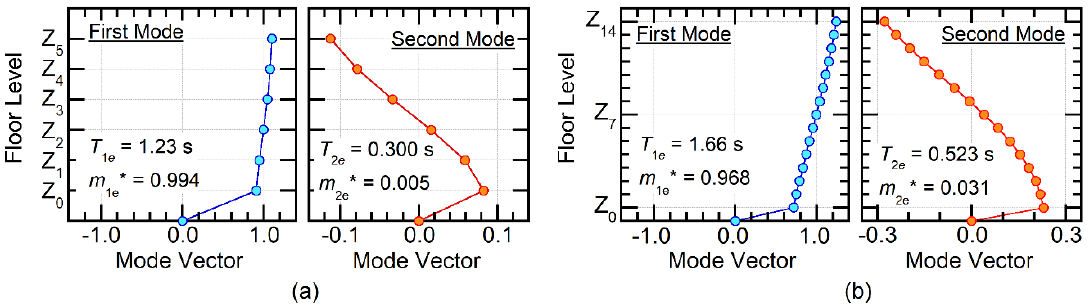
Figure 4. Shapes of the first and second natural mode vectors of the building models in the elastic range: ( a ) Model-05 and ( b ) Model-14.